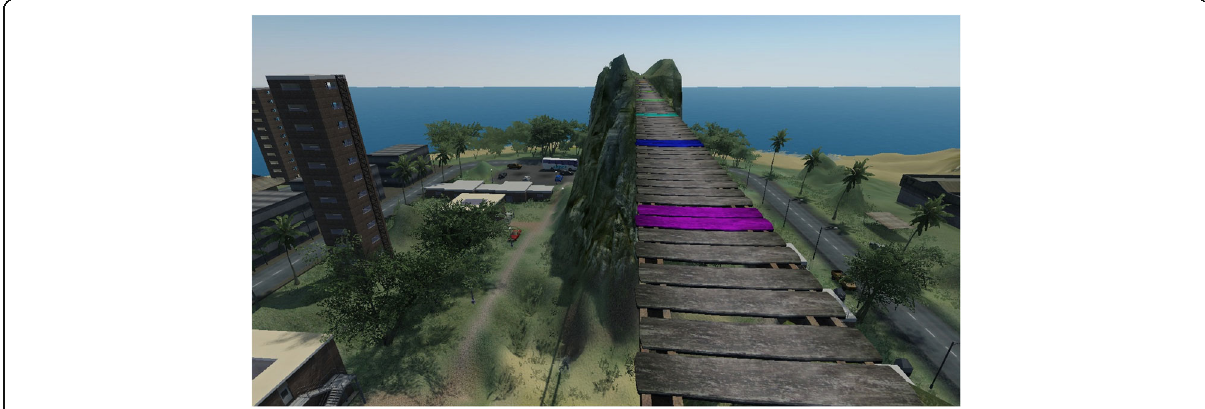
Fig. 1 Screen capture of the virtual environment created for the 18 F-FDG PET scan sensitized by virtual exposure consisting of a 50-m (165 ft) high wooden bridge devoid of any handrails and made of spaced planks. Coloured planks are dependent on the distance covered by the subject while immersed in this virtual environment for calculating the behavioural avoidance test (BAT) score on a 10-point